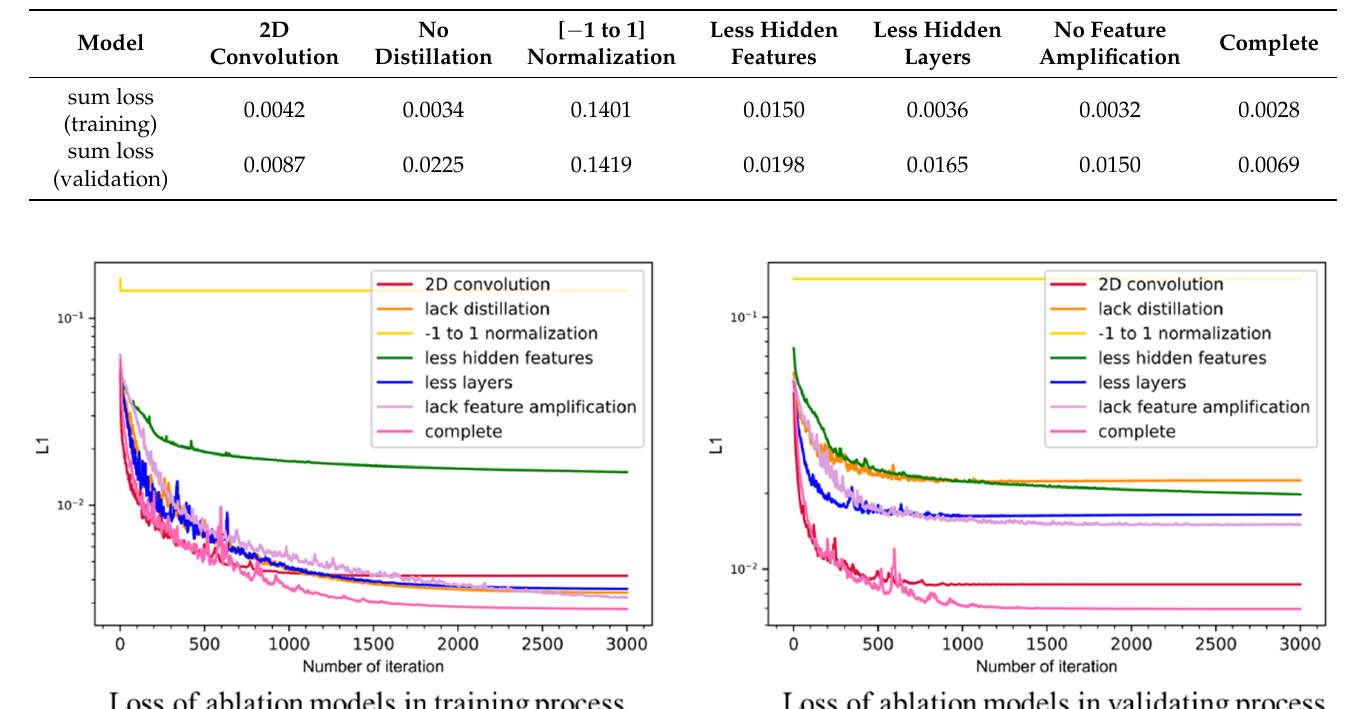
Table 2. The training loss of the complete model and 5 incomplete model.